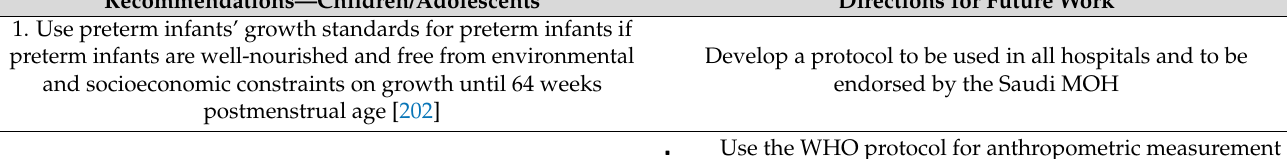
Table 3. Summary of recommendations for establishing Saudi guidelines of anthropometric measure- ments for children/adolescents and directions for future work in line with the Saudi 2030